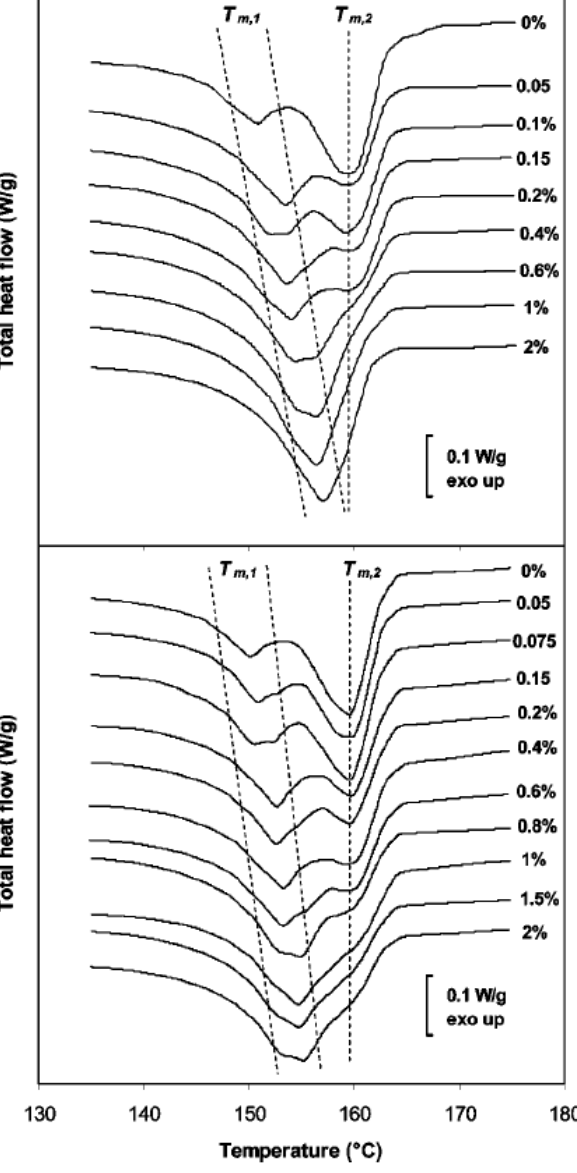
Figure 26. MTDSC total heat flow traces during heating at 2.5 °C/min of iPP nanocomposites containing SWCNTs (top) and MWCNTs (bottom). The dashed lines are guidelines for the eye showing the position of the melting peaks for the different systems ( T marked as a broad melting region and T m,1 permission from ref.